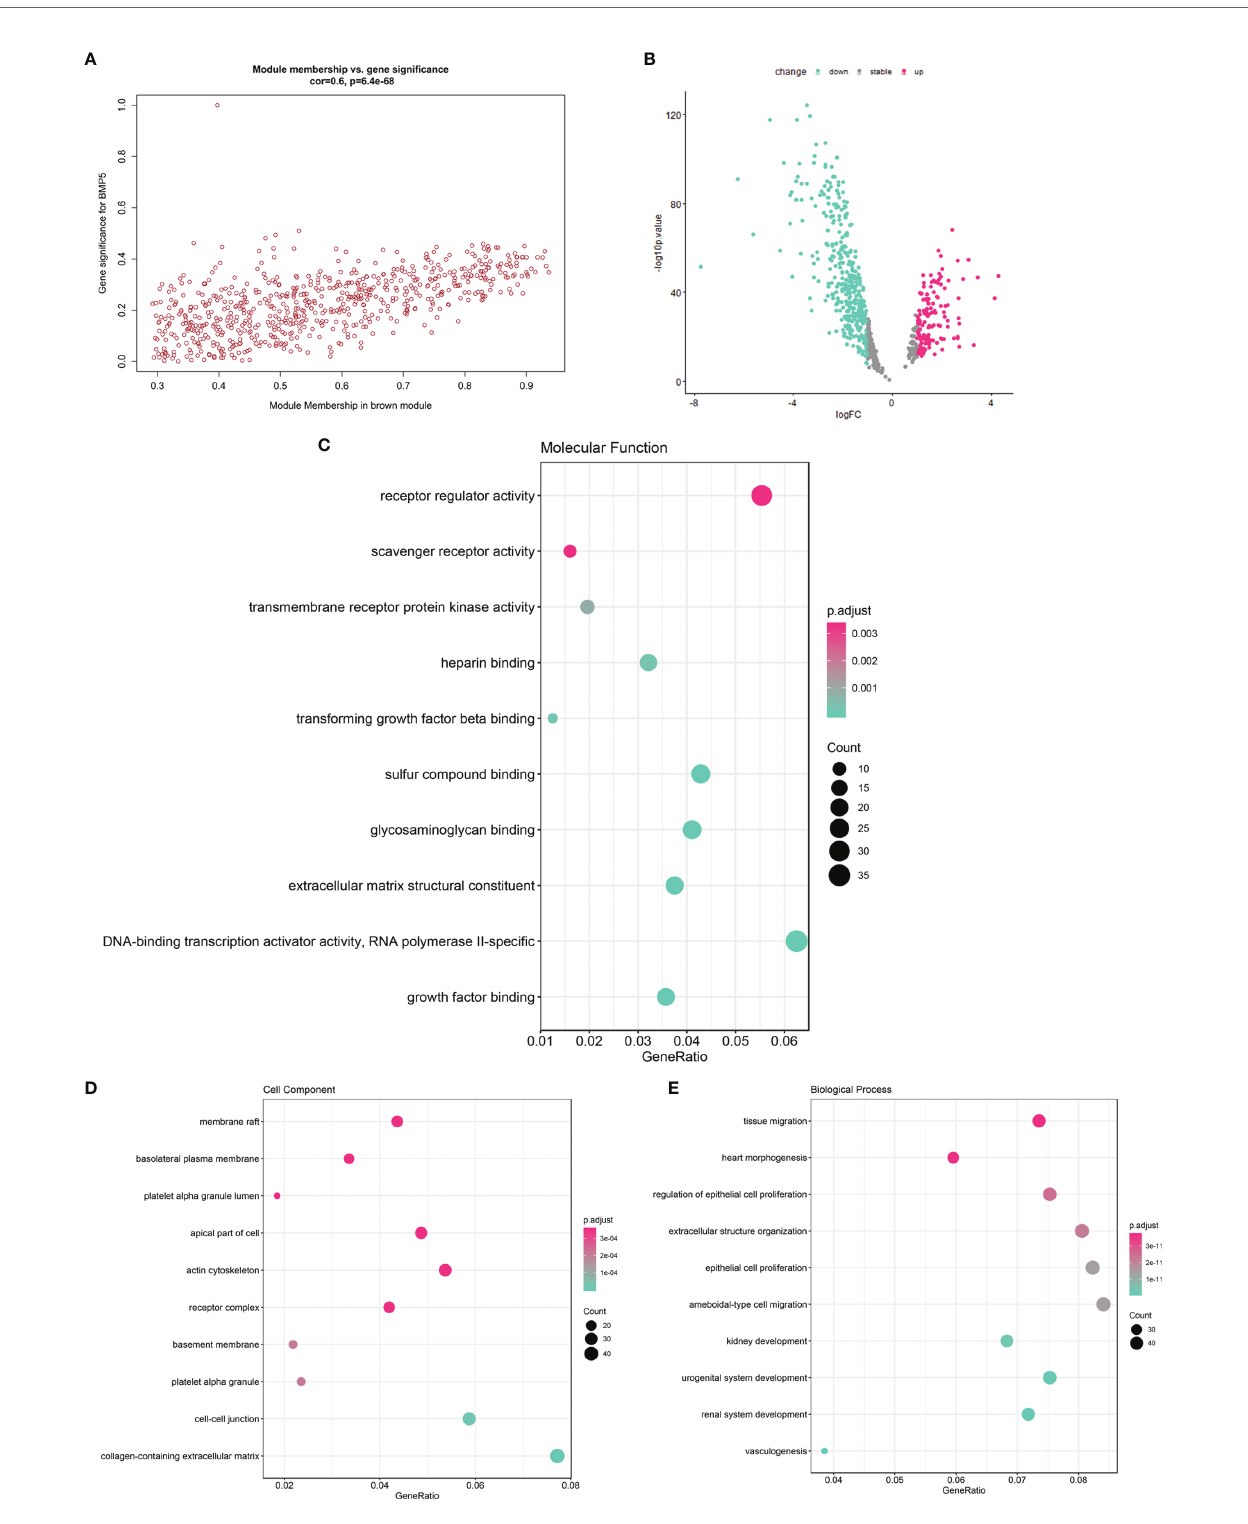
FIGURE 6 | The function enrichment of brown module genes and the identi fi cation of hub genes with prognostic value. (A) The scatter diagram of correlation between brown module genes ( n = 682) and BMP5 expression (correlation: 0.6, p -value: 6.4e-68 < 0.001). (B) The volcano plot of brown module gene expression pro fi le in TCGA-LUAD indicating 537 DEGs (152 upregulated vs. 385 downregulated genes). (C – E) The GO function enrichment of 537 DEGs in terms of molecular function, cell component, and molecular